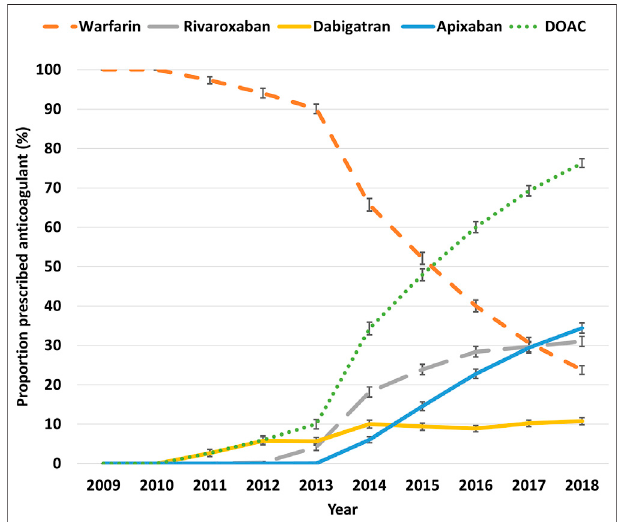
FIGURE 3 | The proportion of patients with atrial fi brillation receiving an oral anticoagulant, 2009 – 2018. Error bars indicate 95% con fi dence intervals.